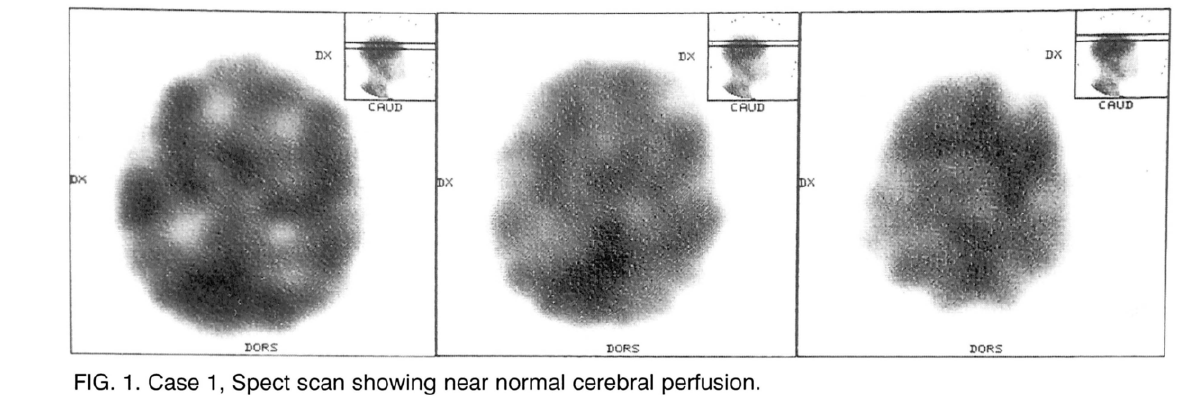
FIG. 1. Case 1, Spect scan showing near normal cerebral